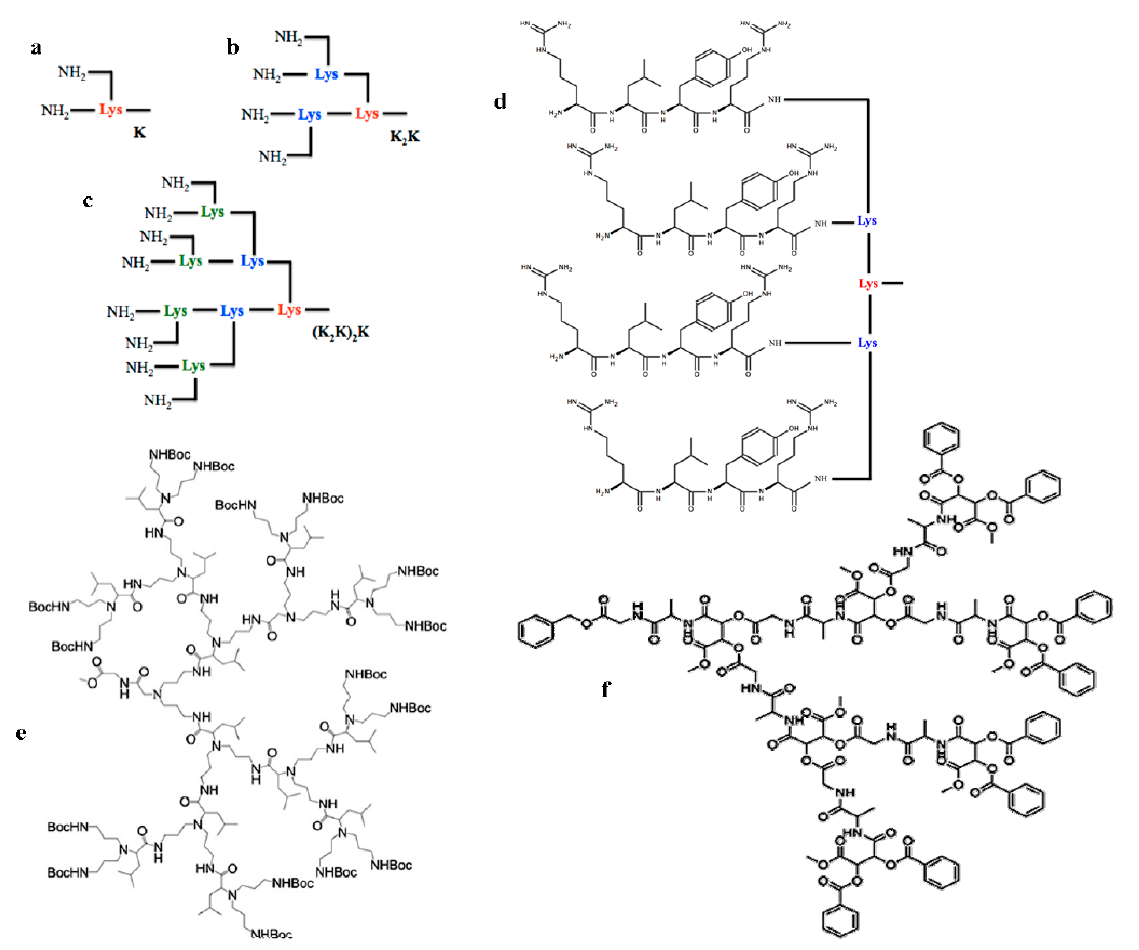
Figure 1. Schematic representations of three types of dendrimeric cores with three generations of lysines shown in different font styles: ( a ) Two-branched Lys (red); ( b ) Four-branched (Lys)2Lys (red-cyan); ( c ) Eight-branched [(Lys)2Lys]2Lys (red-cyan-green); ( d ) (Lys)2Lys core with α and ε branches bearing peptides Arg-Leu-Tyr-Arg; ( e ) An example of peptide dendrimer with L -Leucine dendrimer as the branching unit; ( f ) A depsipeptide dendrimer, a chiral dendrimer owing its name to its structural resemblance to depsipeptides. Arg: arginine; Leu: leucine; Tyr: tyrosine; Lys: lysine. From [17,18].